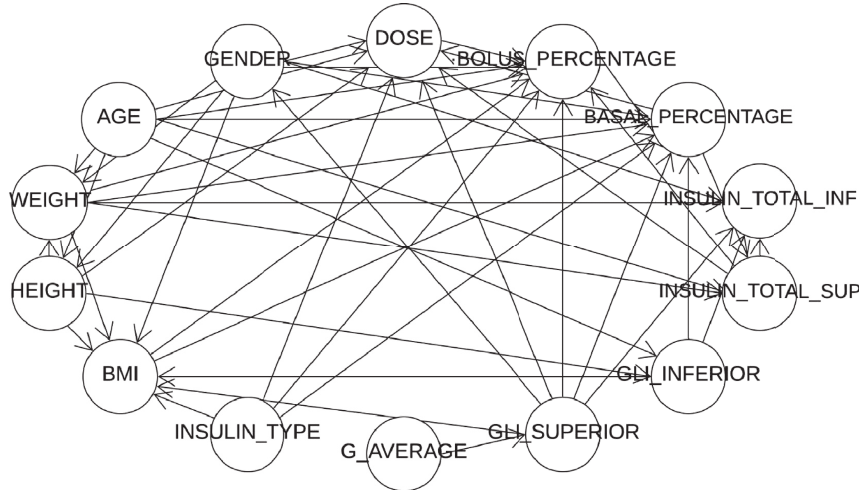
Figure 2: Dependencies in the Bayesian network model.